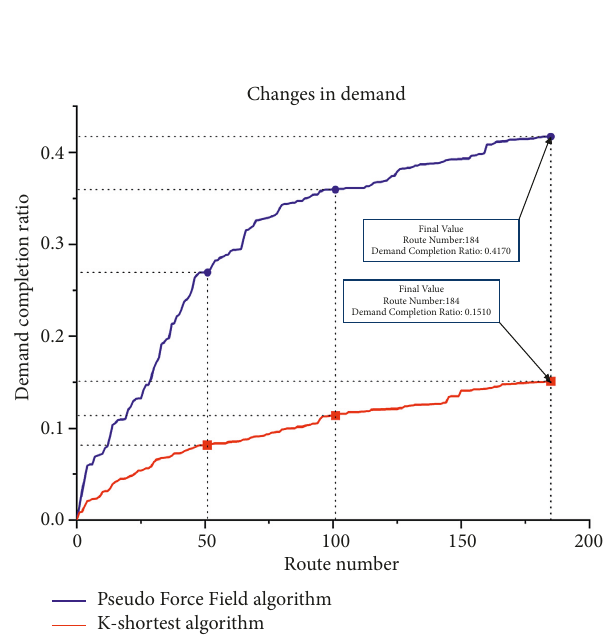
Figure 9: Comparison of KSP algorithm and pseudo force field algorithm.